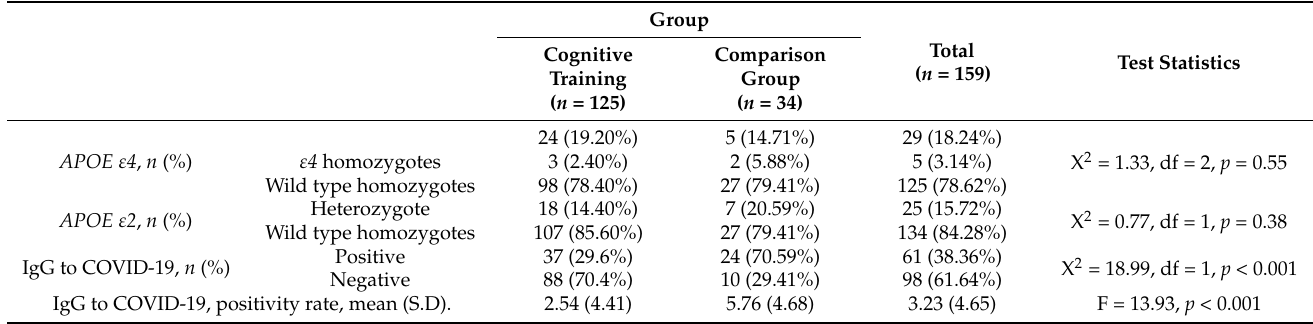
Table 2. Distribution of APOE genotype and anti-COVID-19 IgG in study